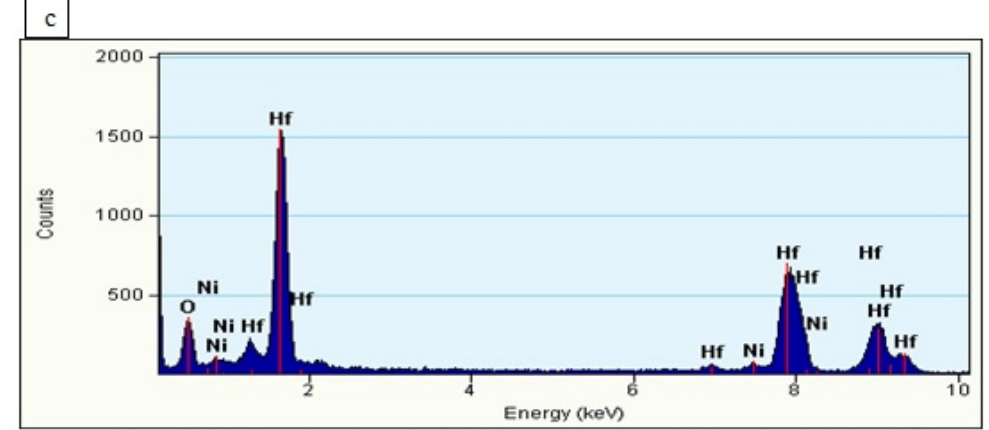
Figure 8. TEM image of the hafnium-rich particle ( a ) with accompanying diffraction ( b ) and ( c ) energy dispersive spectroscope (EDS) spectra.